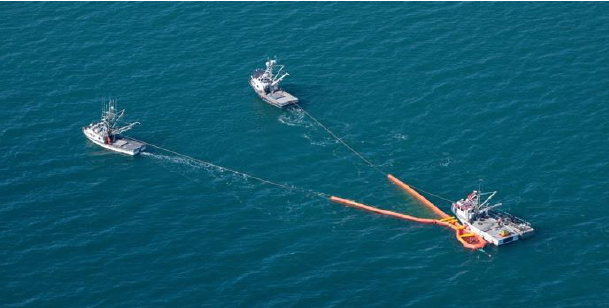
Figure 4 . The example of a nearshore recovery system using a boom and a skimmer [19]. Figure 4. The example of a nearshore recovery system using a boom and a skimmer